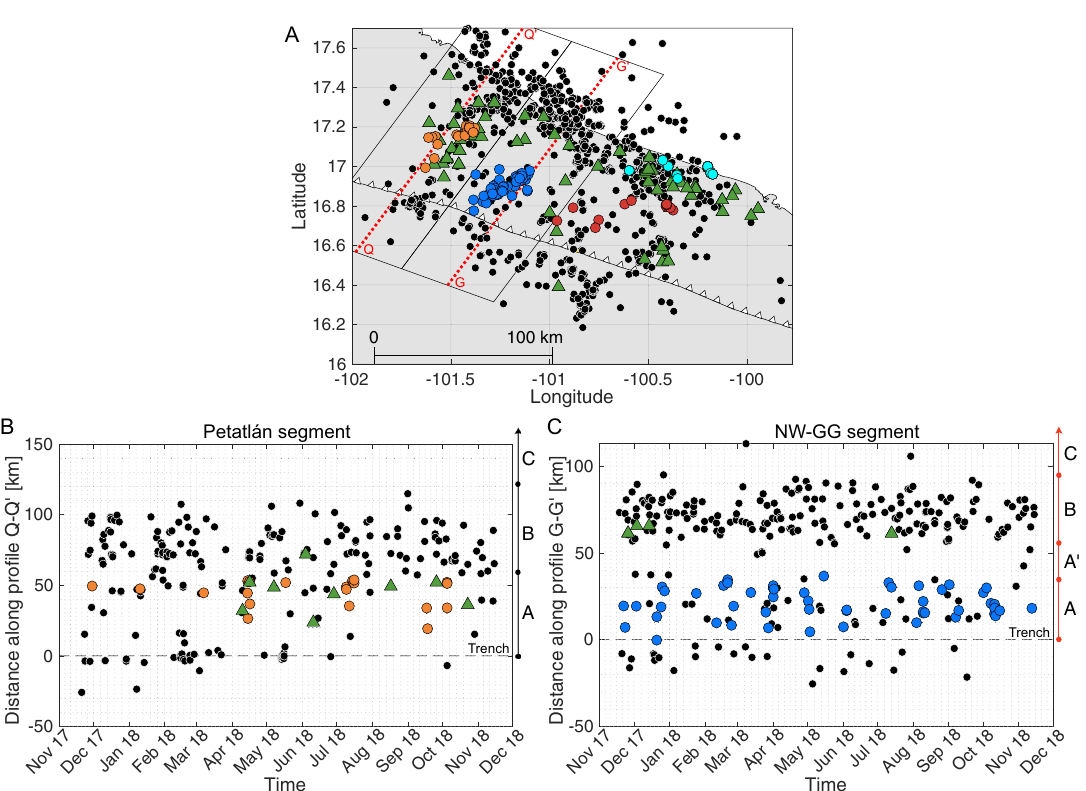
Fig. 3 Pro fi les in the Petatlán and NW-GG segments. A Distribution of STs (coloured circles) into four main clusters as in Fig. 2A. Green triangles and black circles are repeaters and earthquakes, respectively. Red dotted lines are pro fi les G-G ’ and Q-Q ’ for the NW-GG and Petatlán segment, respectively. Rectangles containing the pro fi les, restrict the seismic events included into B and C. B , C Time plot vs distance along pro fi les Q-Q ’ and G-G ’ shown in A . Black dashed line is the location of the trench. Only seismic events located inside the rectangle areas in A and occurring during 2017 – 2018 are plotted. Colours and symbols as in A . Regions described in the main text are shown on the right side of the plots along arrows divided in